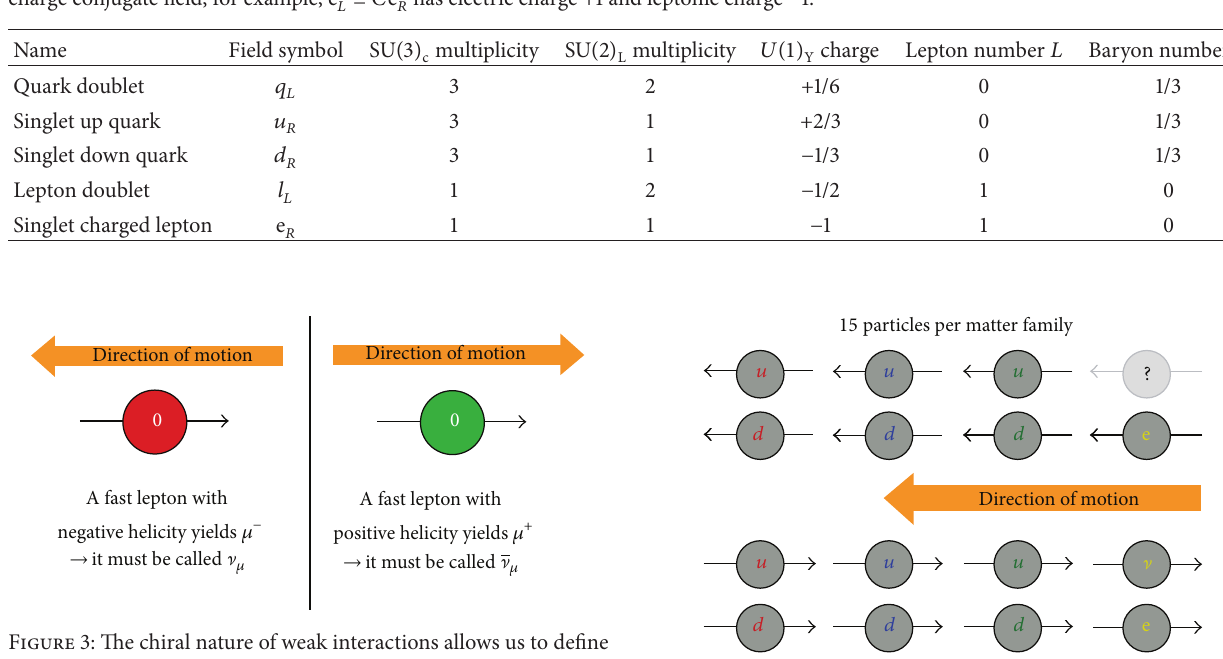
Table 1: List of the matter particles in the SM. The label “singlet” is often replaced with “right” and likewise for “doublet” it can become “left.” Hypercharge is assigned according to 𝑄 = 𝑇 3𝐿 + 𝑌 . The chirality of a field (and all its 𝑈(1) numbers) can be exchanged by considering the charge conjugate field; for example, e 𝑐 𝐿 ≡ 𝐶 e 𝑡 𝑅 has electric charge +1 and leptonic charge − 1.